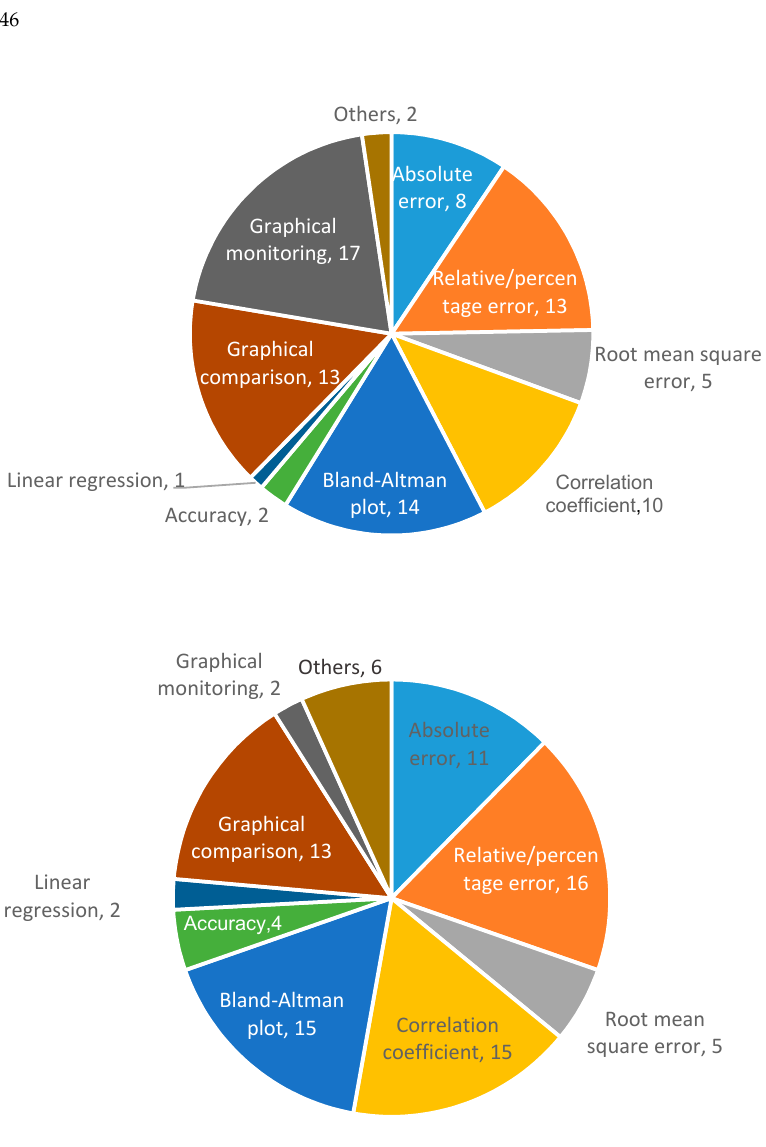
Figure 35. Number of studies using the different figures of merit to determine sensor performance for the wearable ( top ) and environmental ( bottom ) categories.